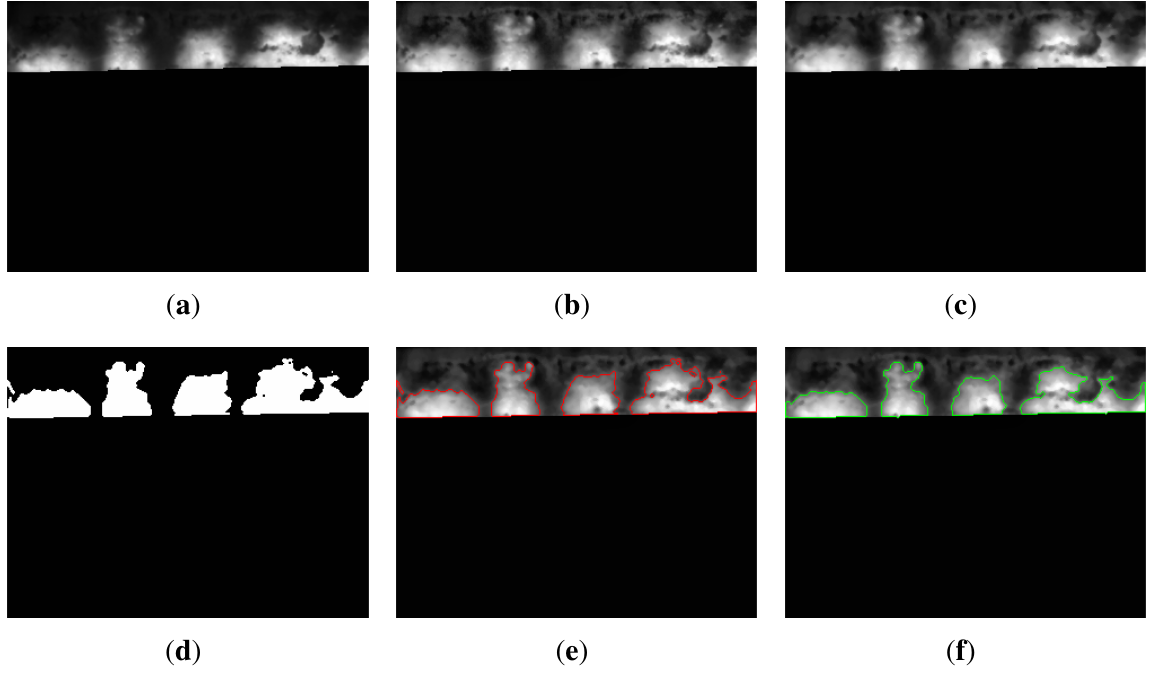
Figure 9. Segmentation of the flame front. ( a ) Input image; ( b ) image after contrast enhancement; ( c ) median filtering of the image; ( d ) binary image after thresholding; ( e ) initial contours; ( f ) final